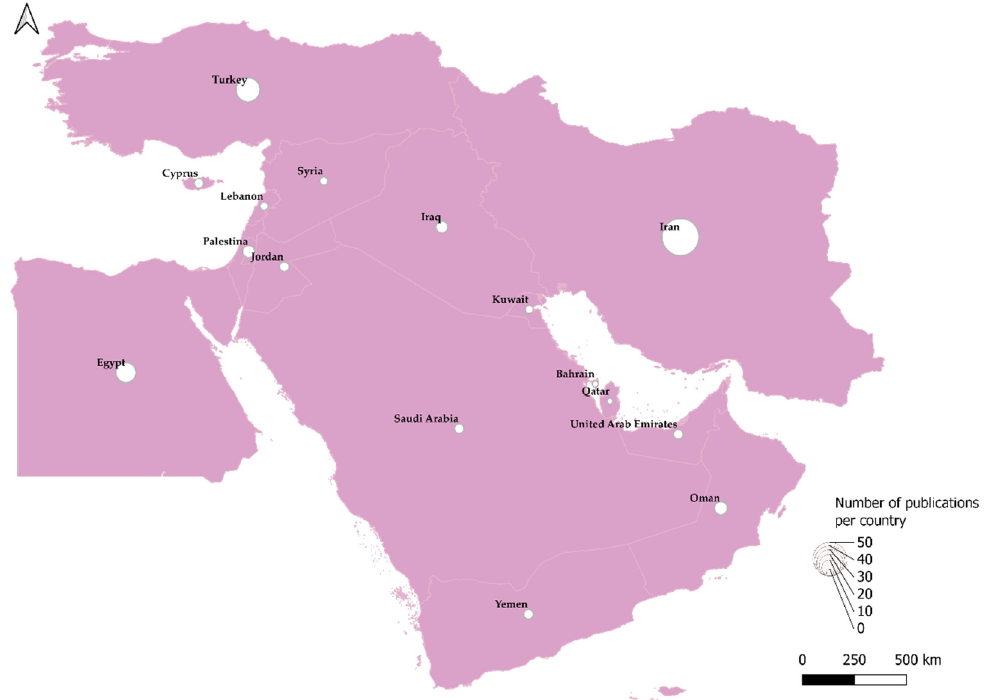
Figure 1. Geographical distribution of the Middle Eastern publications. Map created with DIVA- GIS version 7.5 and designed with QGIS 3.16.1 Hannover.